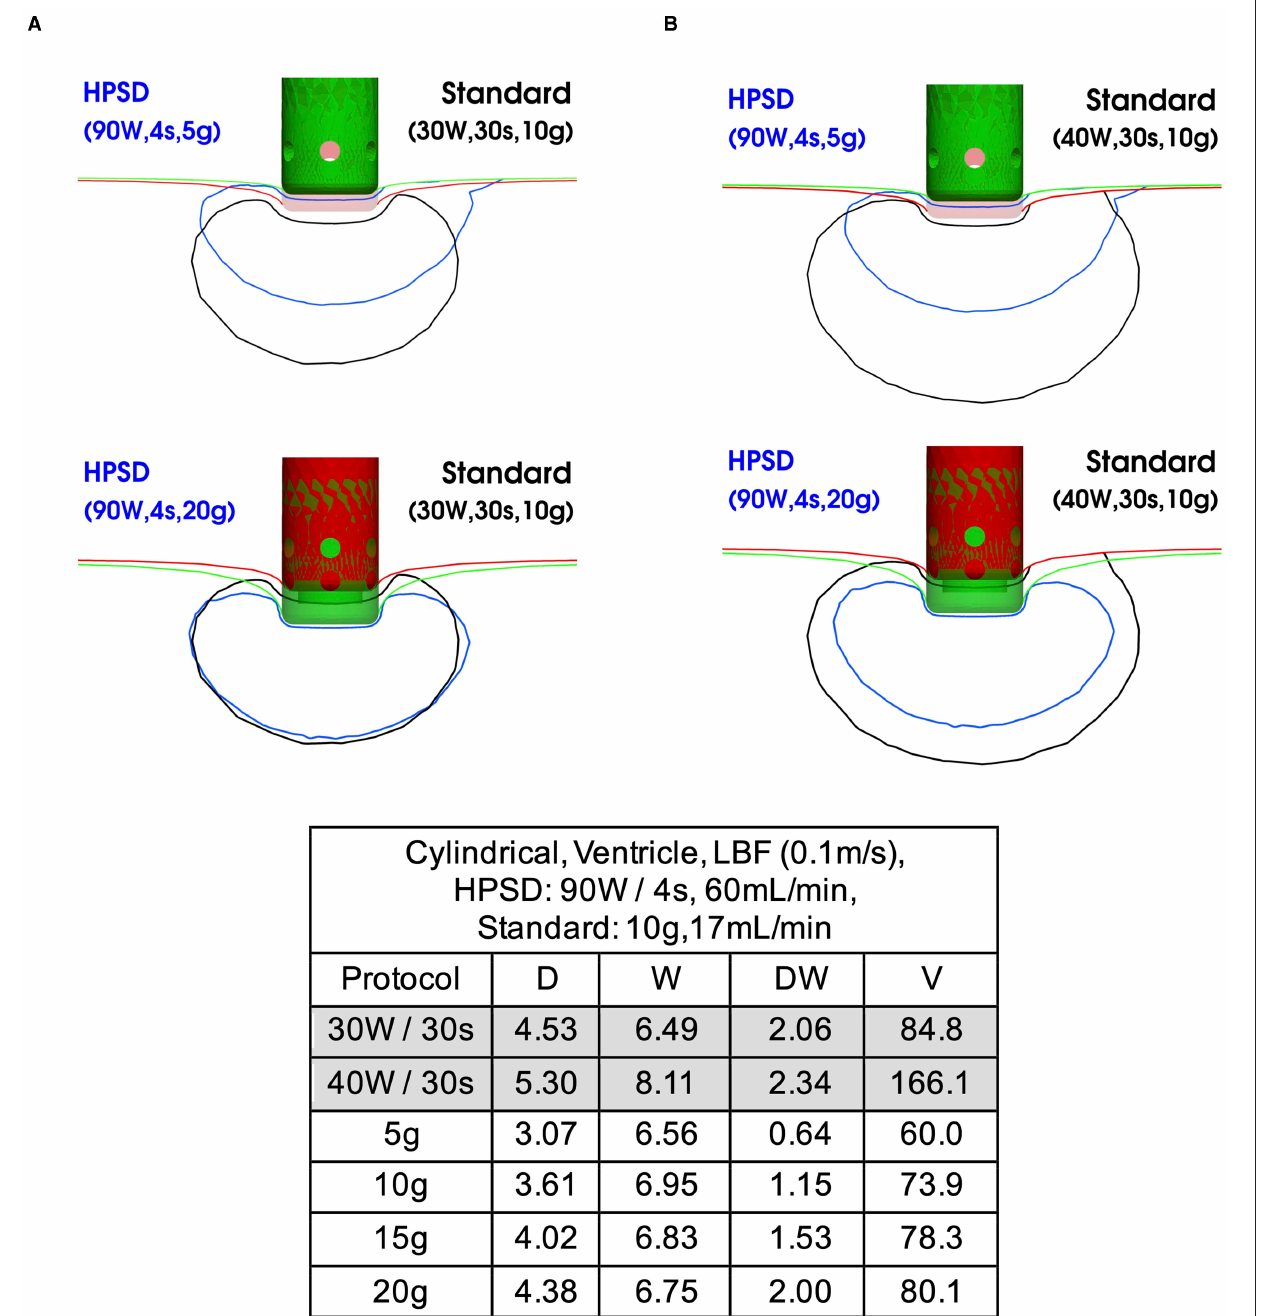
FIGURE 5 | Lesion comparison between 90 W/4s and standard protocols in the ventricle at different CF. The table collects the absolute values. (A) Comparison of 90 W/4s vs. 30 W/30s protocol at CF 5 and 20g; (B) comparison of 90 W/4s vs. 40 W/30s protocol at CF 5 and 20g.